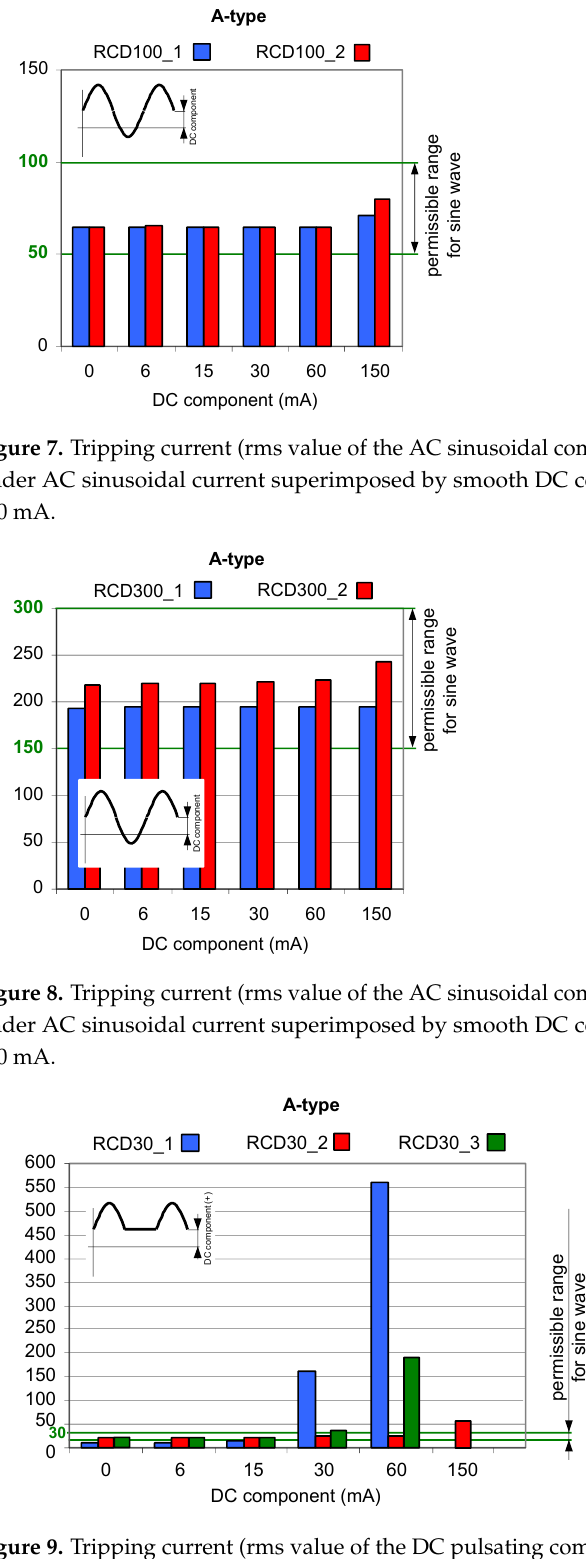
Figure 10. Tripping current (rms value of the DC pulsating component) of two 100 mA A-type RCDs under pulsating DC (half-wave) current superimposed by smooth DC component of values 6, 15, 30, 60, and 150 mA. Both components have positive (+) polarity. Figure 11. Tripping current (rms value of the DC pulsating component) of a 300 mA A-type RCD (symbol RCD300_2) under pulsating DC (half-wave) current superimposed by smooth DC compo- nent of values 6, 15, 30, 60, and 150 mA. Note — the smooth DC component may have a positive (+) polarity (left-side bars) or a negative ( − ) polarity (right-side bars).